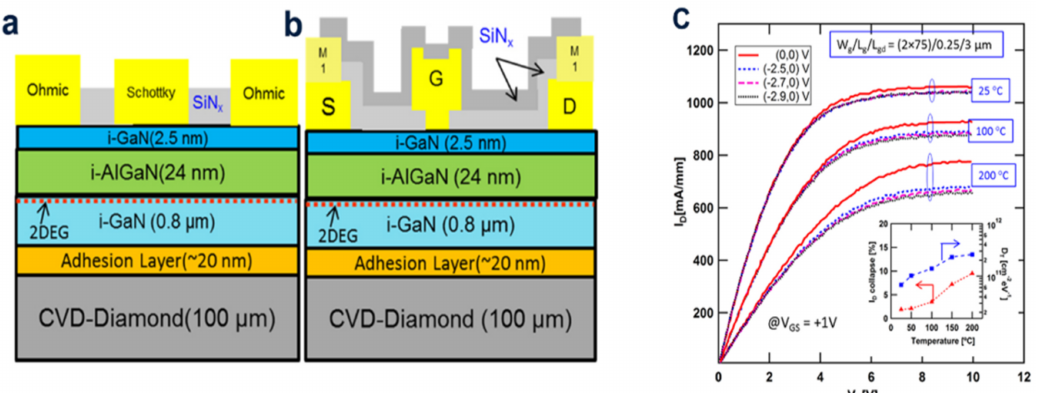
Figure 5. ( a ) Transverse-truncated surface sketch map of AlGaN/GaN: ( a ) Schottky diode, ( b ) The 0.25 µ m palisade HEMTs on the CVD-diamond underlayment. ( c ) Temperature-dependent pulsed I DS –V DS peculiarity of HEMTs stressed under different static bias voltages. (Inset) Inner diameter collapse and DT variation at all sorts of temperatures (25–200 ◦ C).